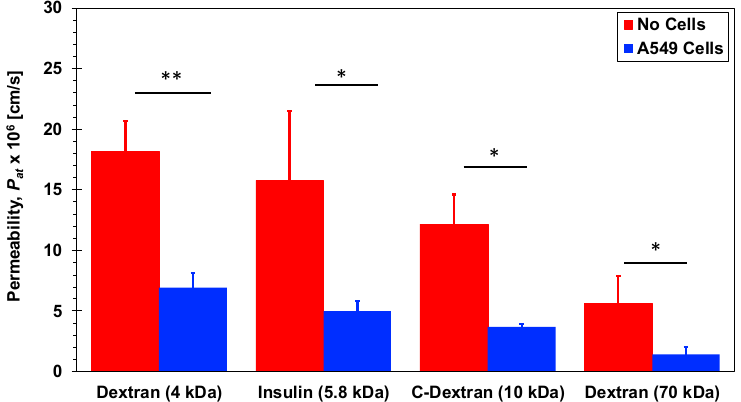
Figure 3. Permeability of 4-dextran, C-dextran, 70-dextran, and insulin in Transwells with and without A549 cell monolayers. Significance determined with student’s T-test with unequal variance (n = 3); * p < 0.05, ** p < 0.01.